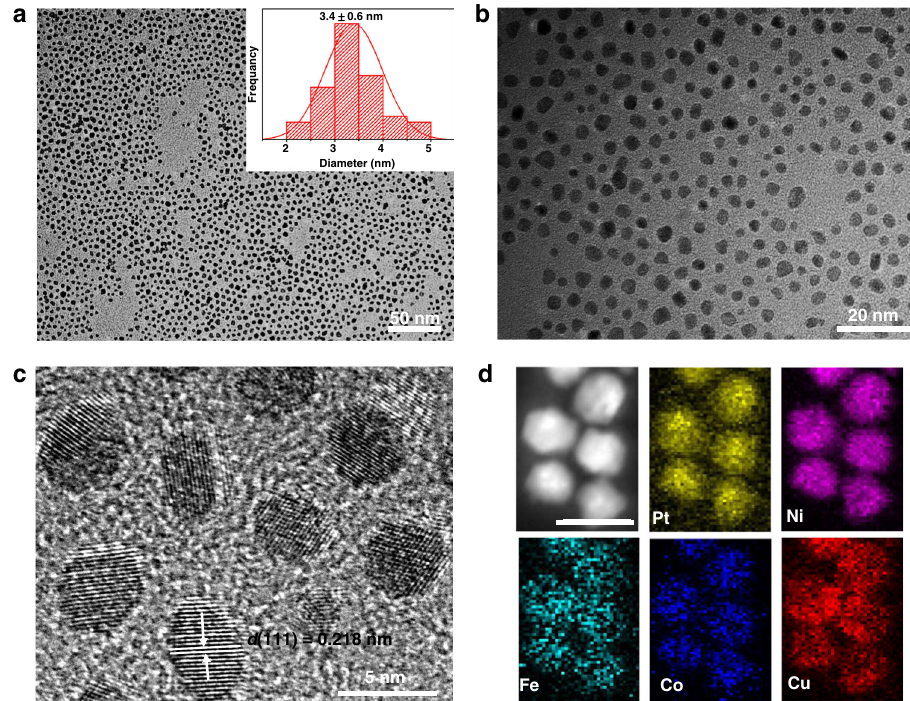
Fig. 1 TEM images and elemental mapping analysis. a , b TEM images of Pt 18 Ni 26 Fe 15 Co 14 Cu 27 nanoparticles. c HRTEM image of Pt 18 Ni 26 Fe 15 Co 14 Cu 27 nanoparticles. d The corresponding elemental mapping of Pt